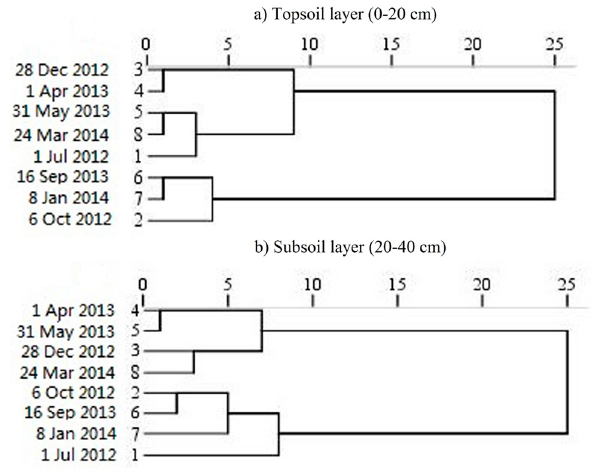
Figure 4. Dendrogram of soil moisture in the top ‐ and subsoil layers using Between ‐ groups linkage.